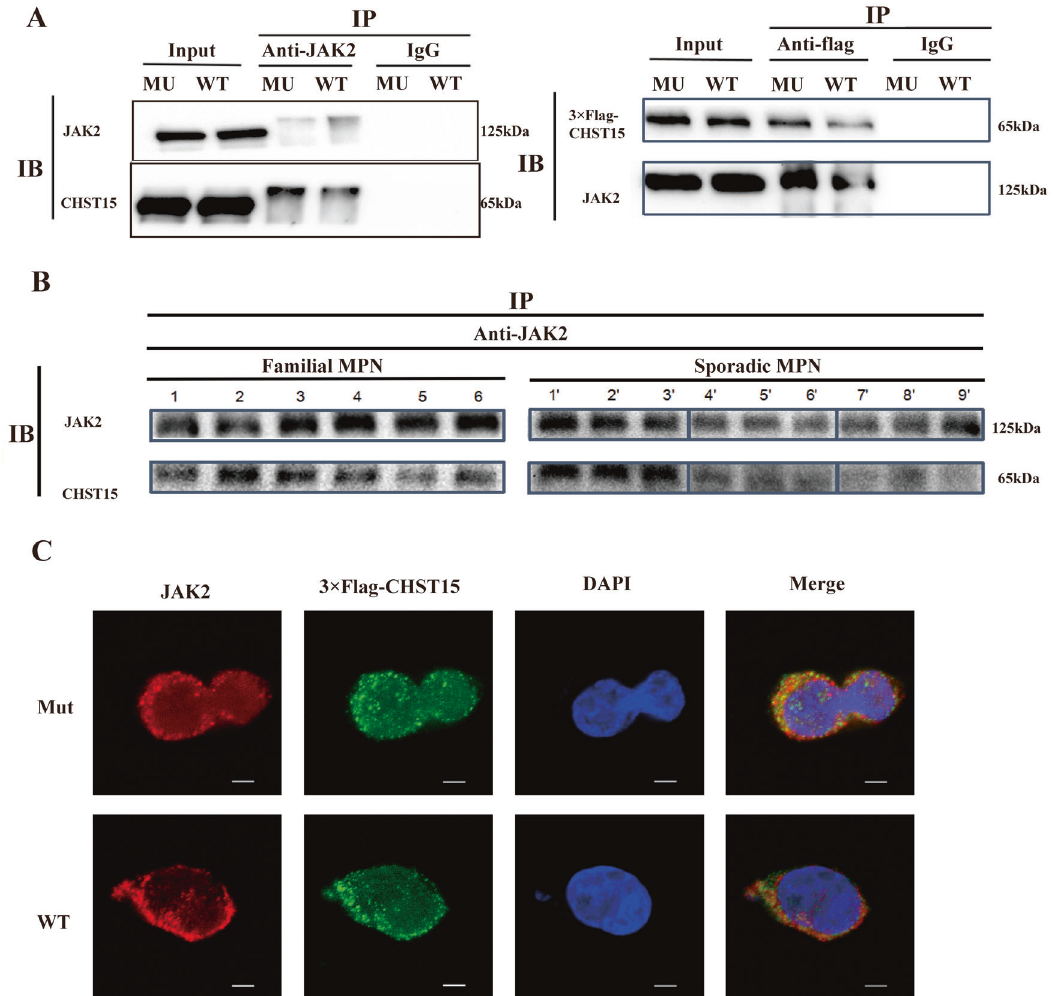
Fig. 6 JAK2/CHST15 complex formation. A Coimmunoprecipitation between JAK2 and CHST15 on HELcells harbouring CHET15 mutation ( CHST15 R456fs ) or wild-type CHST15 . left panel: anti-JAK2 antibody; right panel:anti- Flag- CHST15 antibody. Input, non-immunoprecipitated cell lysates; IgG, control IP with isotype antibody. B Coimmunoprecipitation between JAK2 and CHST15 on primary PBMNCs of patients with familial MPN (left panel: 1, 2, Familial 1. PMF: 3, 4. Familial 3. ET; 5,6. Familial 2, PMF.) or sporadic MPN (right panel: 1 ’ , 2 ’ , 3 ’ : sporadic MPN with JAK2V617F ; 4 ’ , 5 ’ , 6 ’ : MPN with CALR mutation; 7 ’ ,8 ’ ,9 ’ : MPN without mutation- triple negative). C Immuno fl uorescent colocalization of FLAG- tagged- CHST15 and JAK2 . 4 ′ ,6-diamidino-2-phenylindole (DAPI) wasused for nuclear staining. The results show that both JAK2 and CHST15 are mainly found on cytomembrane and cytoplasm, and form co-precipitatation with granular shape between CHET15 and JAK2 , suggesting exists in physical interaction both JAK2 and CHST15 (wild type) especially CHST15 R456fs mutant.